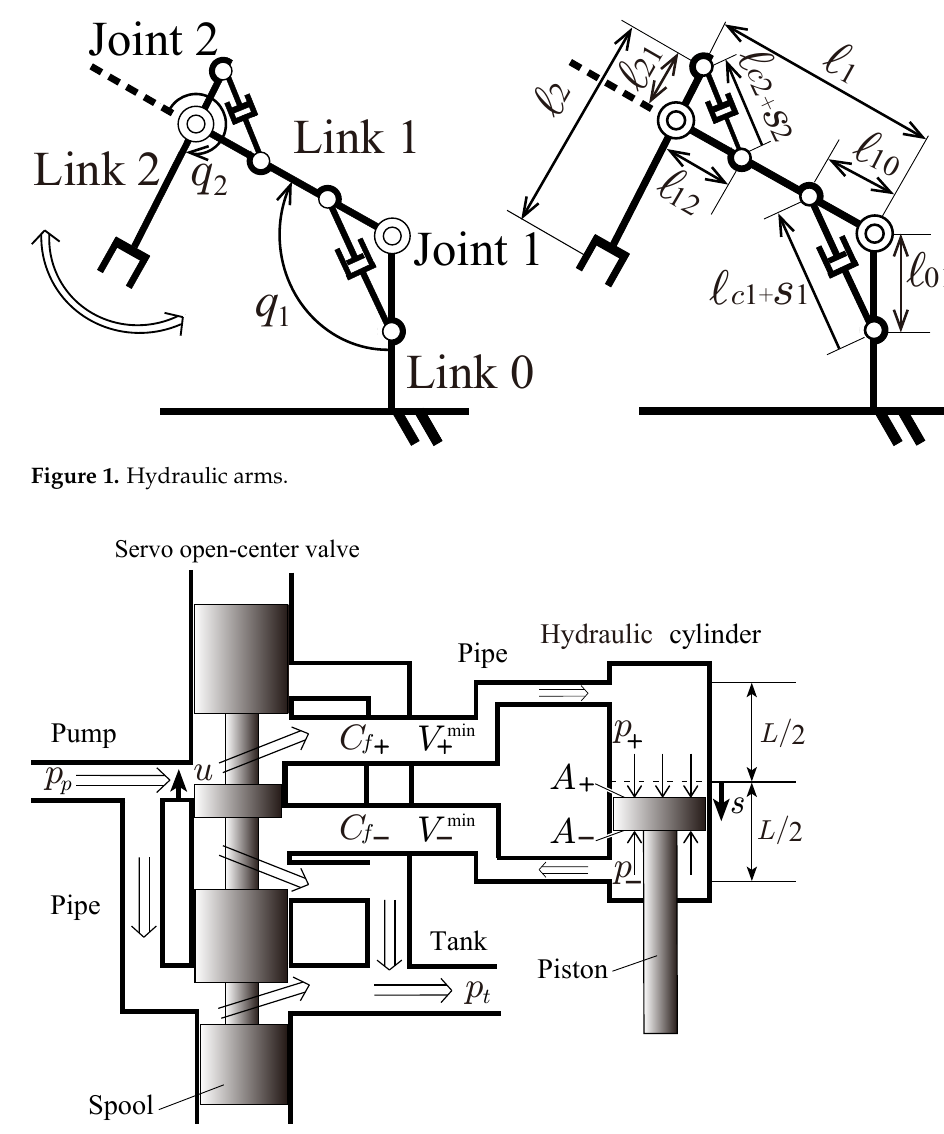
Figure 2. A hydraulic cylinder, pipes, and an servo open-center valve (the joint number is reduced for